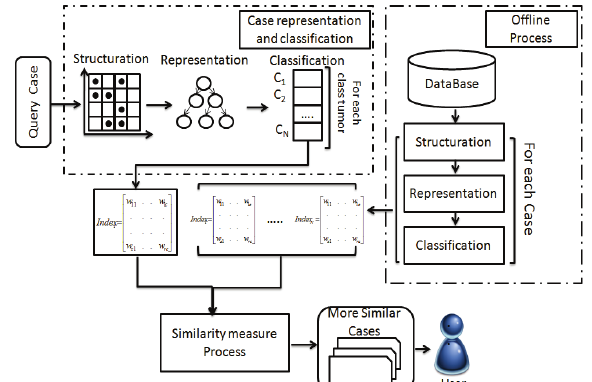
Fig. 2. Overview of the retrieval system based on Bayesian